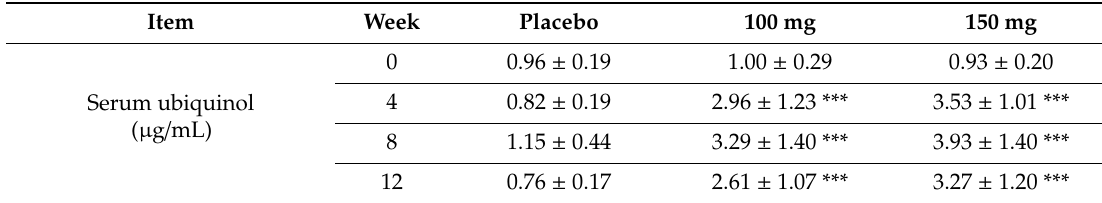
Table 2. E ff ects of ubiquinol by dosage